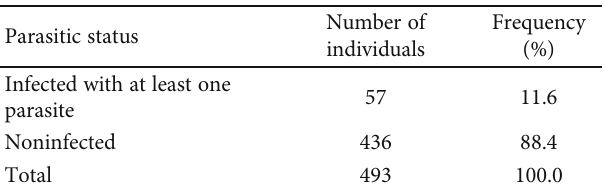
Table 2: The overall percentage of infected and noninfected